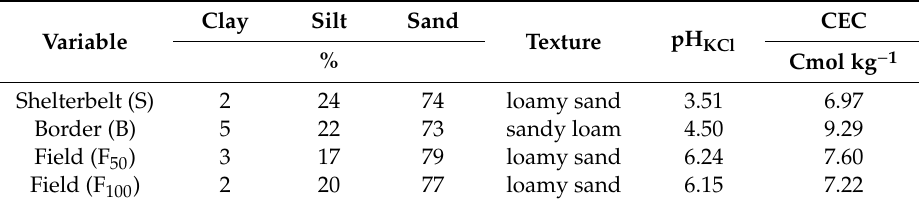
Table 1. Physicochemical properties of the topsoil (0–15